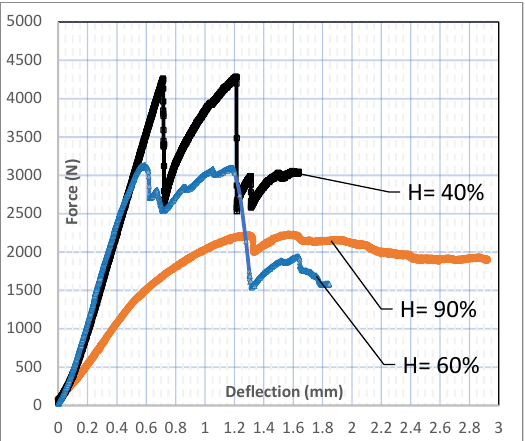
Figure 10. Three-point shear test force – deflection diagrams under different environmental humidity conditions — exposure time = 21 Days.